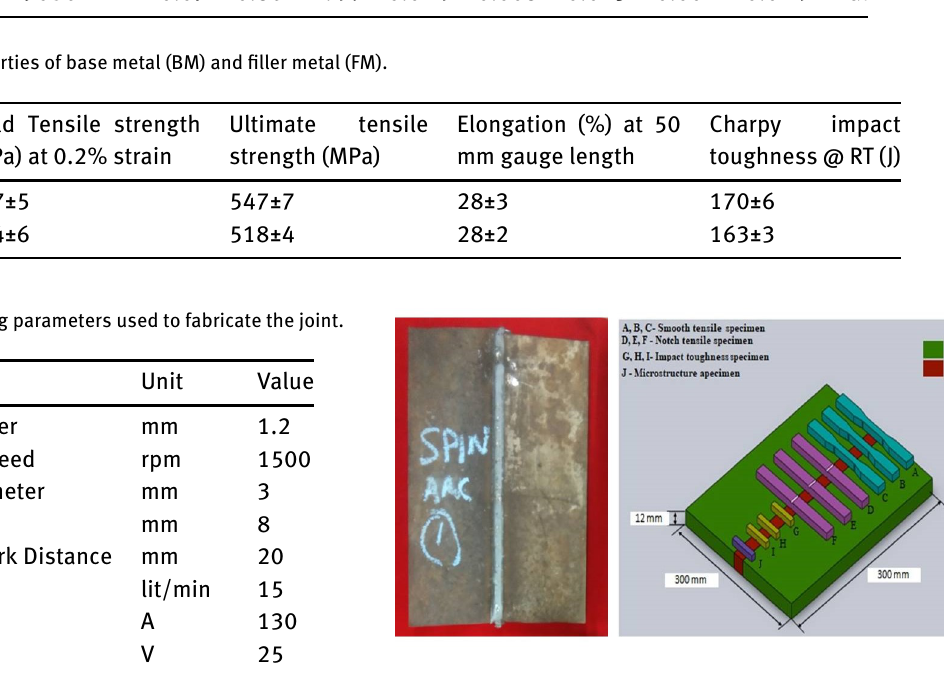
Figure 4: Welded joint photograph and scheme of extraction from the weld